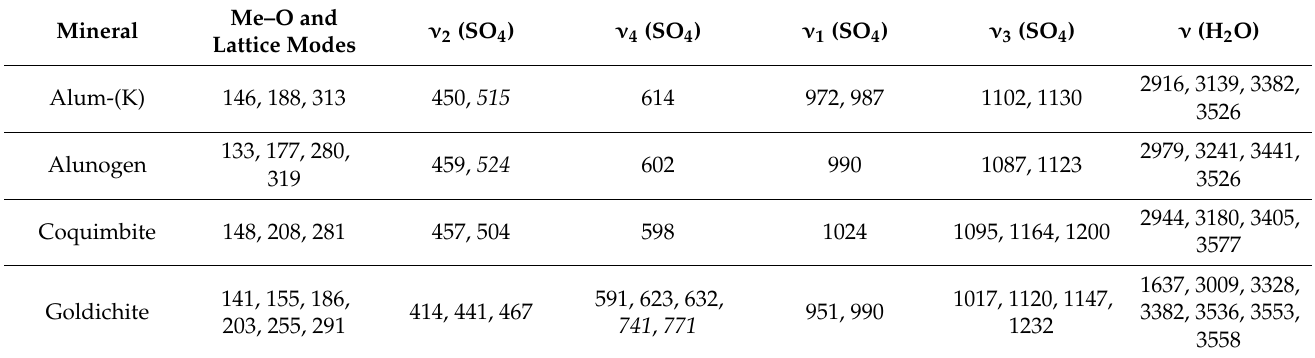
Table 3. Raman bands (in cm − 1 ) and their assignments for the studied sulfates.